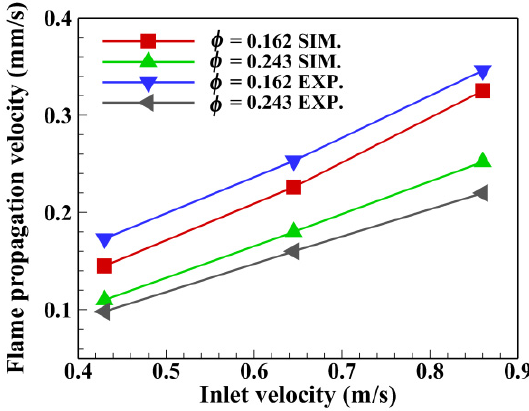
ff ect of gas mixture inlet velocity on the flame propagation Figure 9. Effect of gas mixture inlet velocity on the flame propagation velocity. Figure 9. E